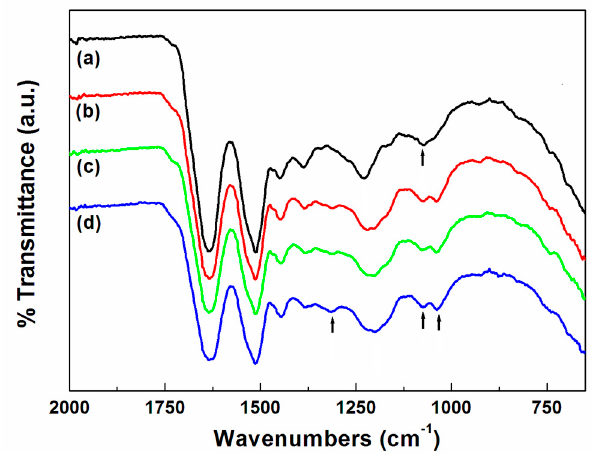
Figure 2. Fourier transform infrared-attenuated total reflectance (FT–IR-ATR) spectra of wool fabrics dyed with spent coffee extract for 60 min as a function of dyeing temperature (all dying samples were mordanted with 1 wt % tannic acid aqueous solution): ( a ) untreated, ( b ) 60 ° C, ( c ) 90 ° C, and ( d ) 120 ° C.